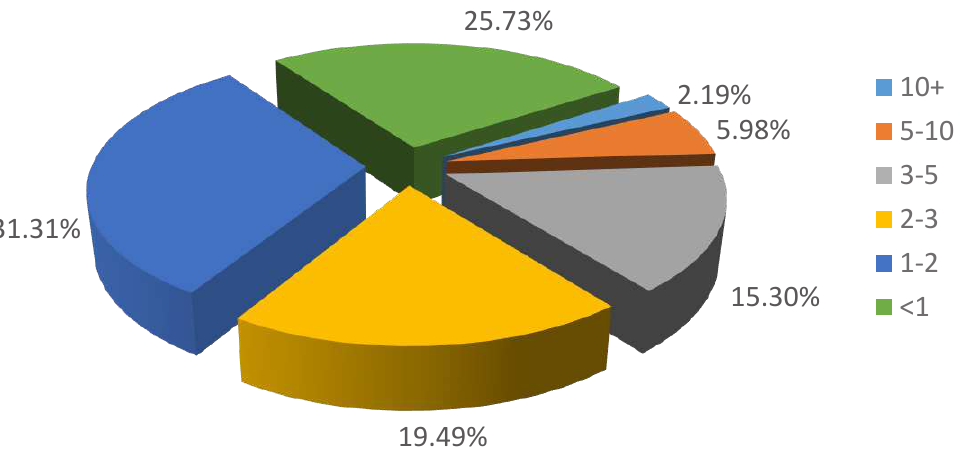
Figure 2. Distribution of JCR-covered journals for 2019 against JIF 2018 ranges